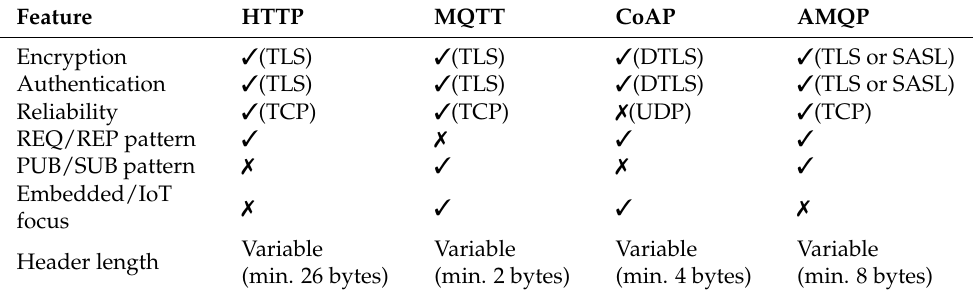
Table 1. Comparison between several application layer protocols.